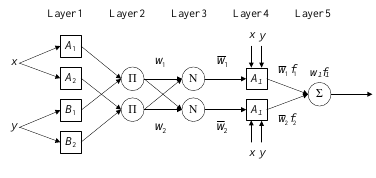
Figure 2. Adaptive neuro-fuzzy inference